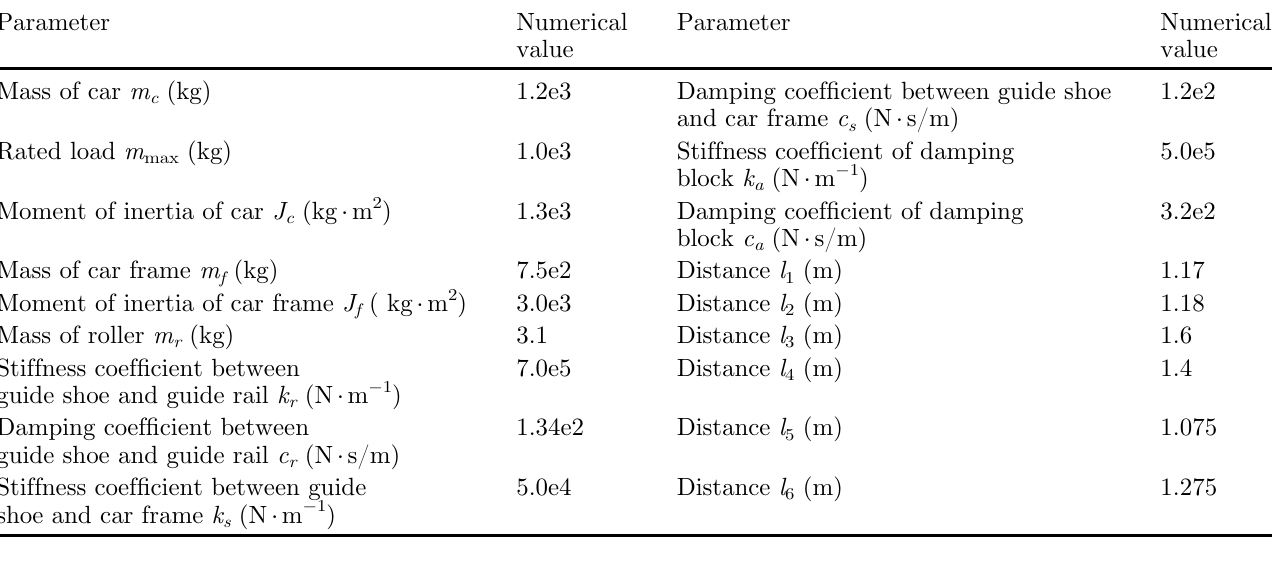
Table 1. High-speed elevator parameters.